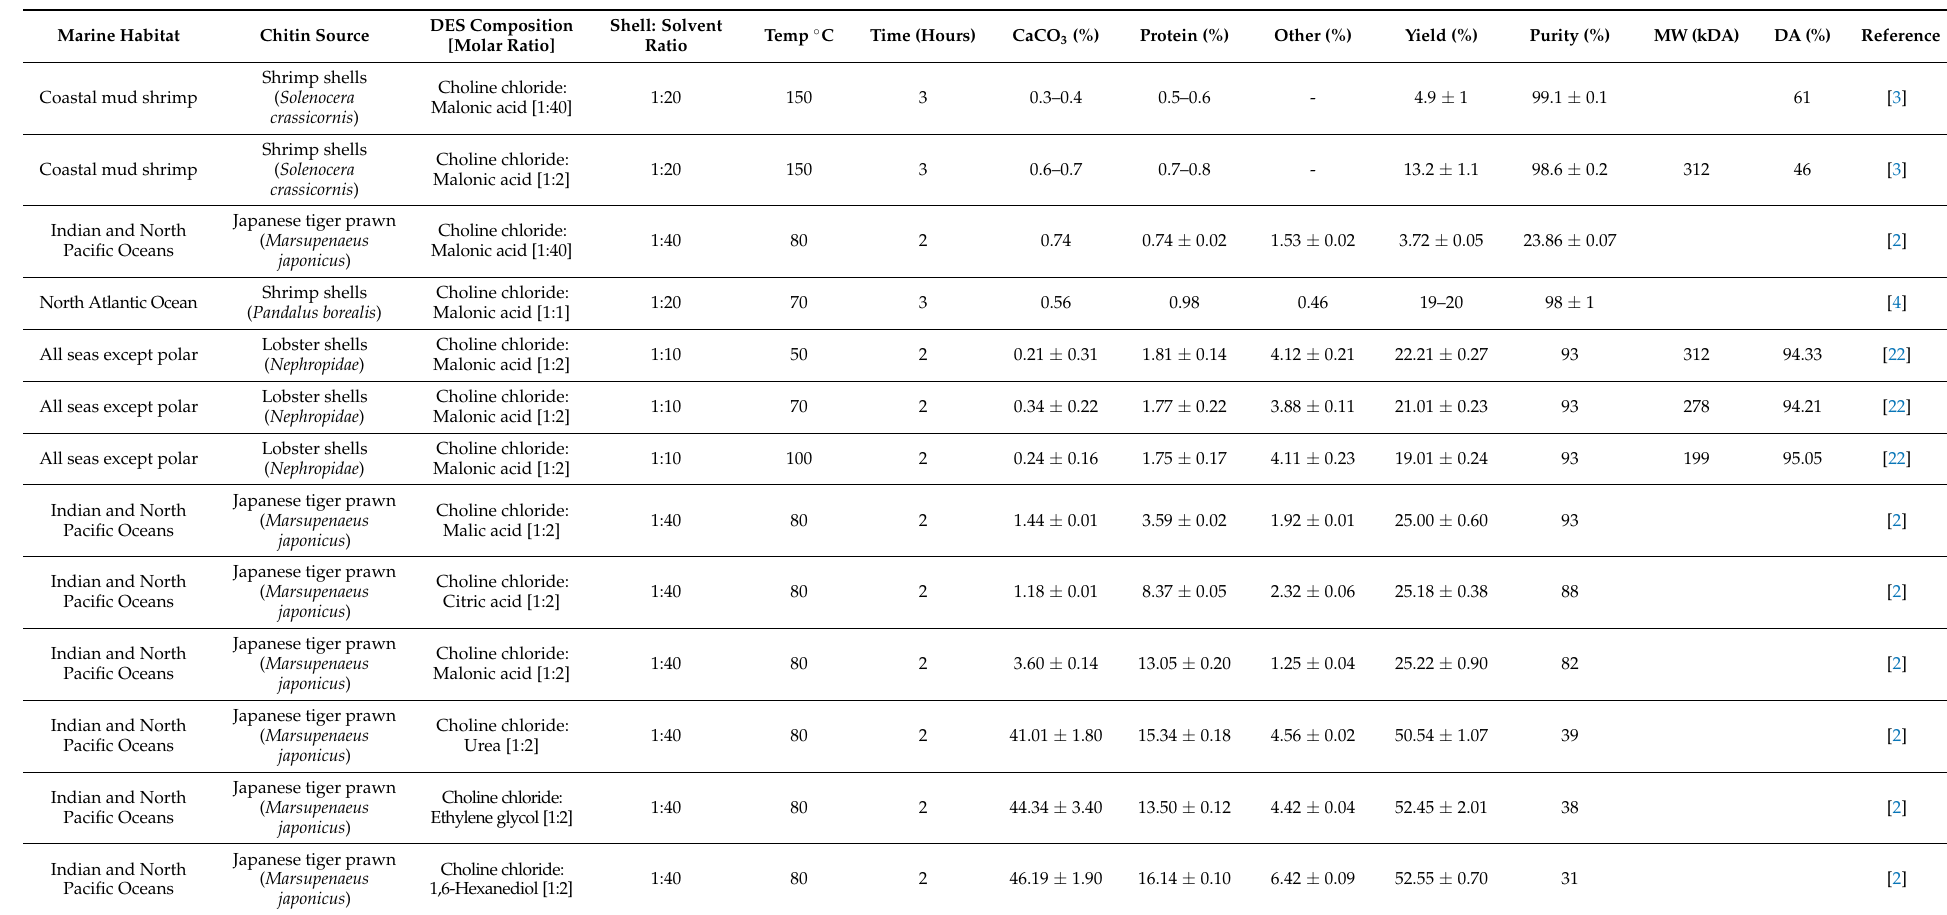
Table 3. The purity, yield, and constituents of extracted chitin using DES-mediated